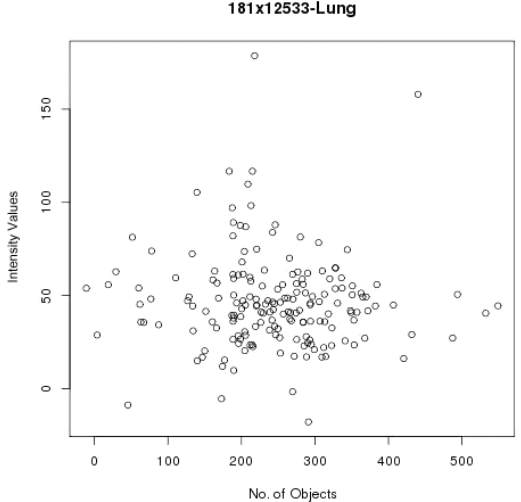
Fig. 7. Lung database.